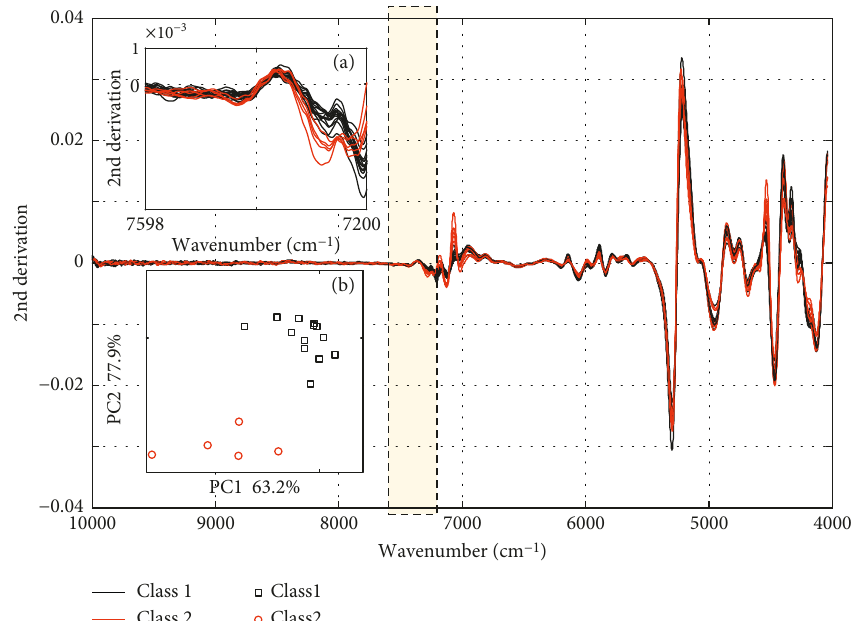
Figure 7: Comparison of Class 1 and 2 in the spectral space and principal component space. (a) The 2nd derivative preprocessed spectra of Class 1 and 2 between 7200cm − 1 and 7598cm − 1 . (b) The first and second scores of Class 1 and 2 using the 2nd spectra between 7200cm − 1 and 7598cm − 1